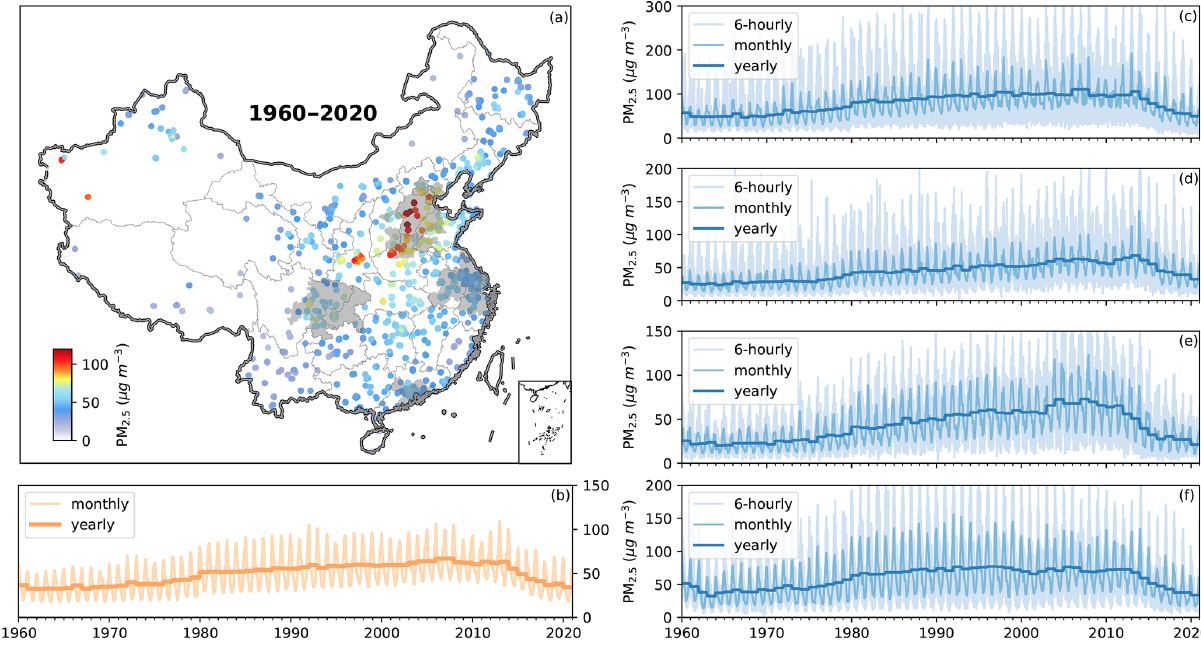
Figure 6. (a) The spatial distribution of average PM 2 . 5 mass concentrations between 1960–2020 and the (b–f) time series of average PM 2 . 5 mass concentrations for all sites in China (b) , “2 + 26” cities (c) , Yangtze River Delta (d) , Pearl River Delta (e) and Sichuan Basin (f) ,